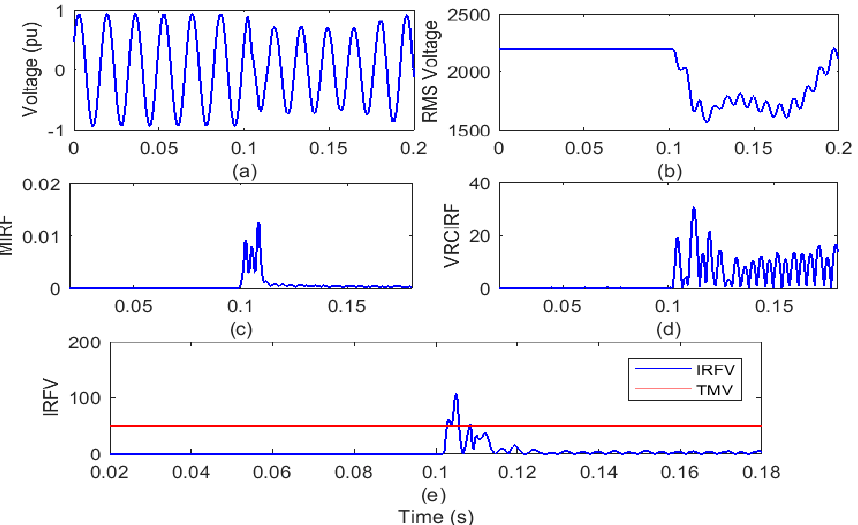
Figure 4. Islanding event in the presence of both wind and solar power generation ( a ) voltage sig- nal ( b ) root means square value of voltage ( c ) median-based IRF ( d ) rate of change in voltage-based IRF ( e ) islanding recognition factor based on voltage.